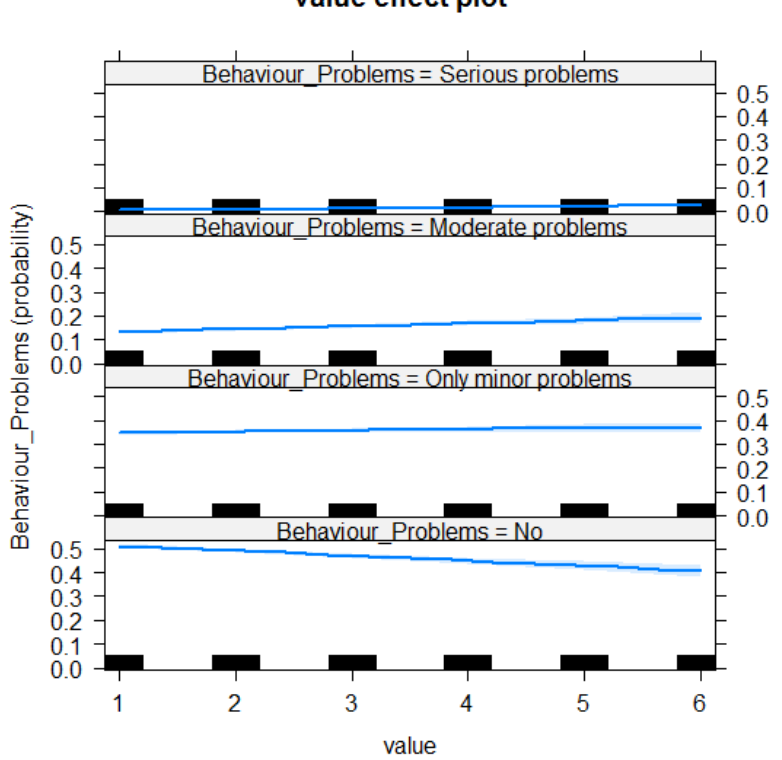
Figure 2. Value e ff ect plot for the unridden horse questionnaire items showing the probability Figure 2. Value effect plot for the unridden horse questionnaire items showing the probability of of behaviours reported by the four self-reported categories (no problems, only minor problems, moderate problems and serious problems). The more undesirable or dangerous the behaviours reported were, the higher the value scored for the horse. Value 1 represents not applicable / not observed, value 2 represents never and value 6 represents